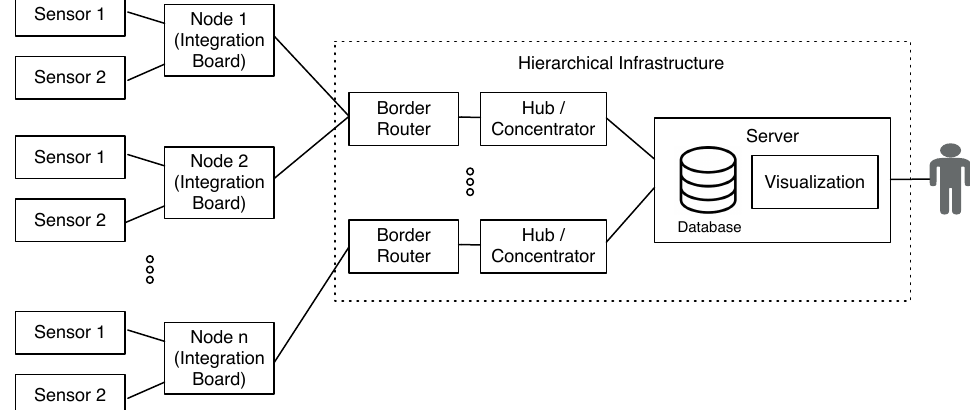
Figure 4. Pilot 4.0 network architecture, comprising an scalable and hierarchical